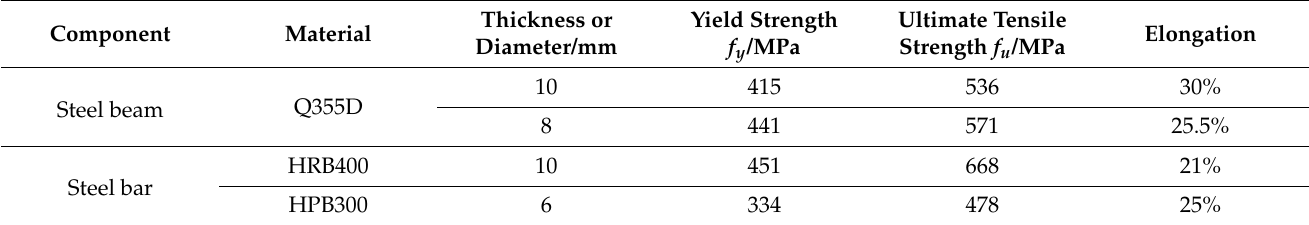
Table 2. Mechanical properties of the steel bar and steel